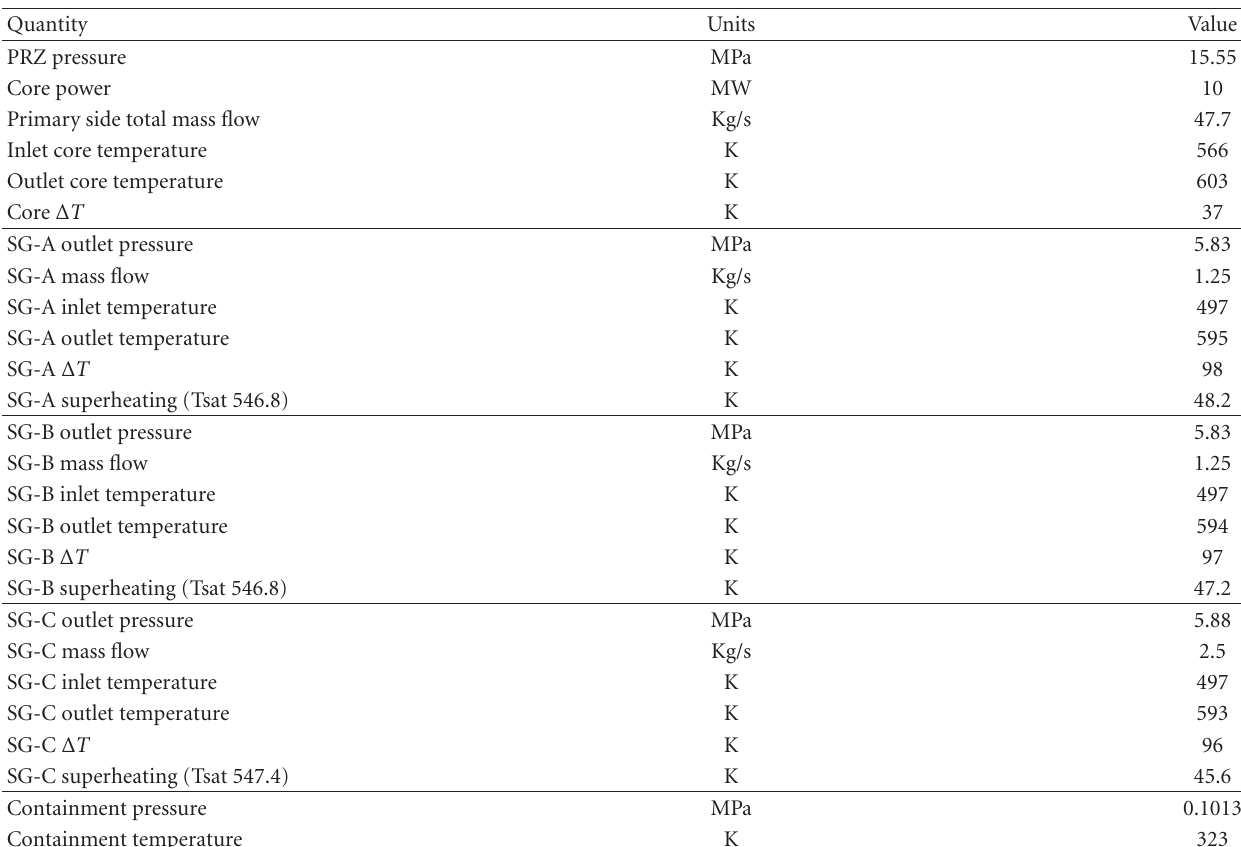
Table 3: SPES3 calculated steady state